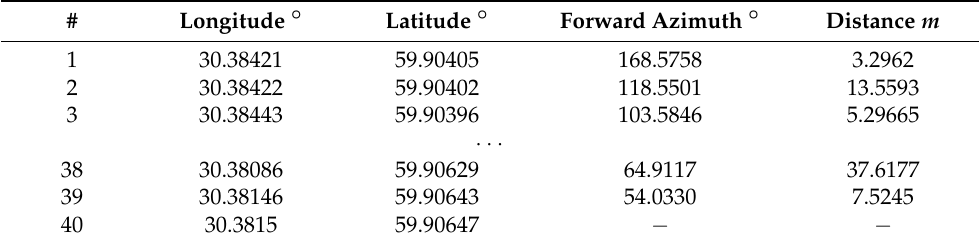
Table 3. Car route